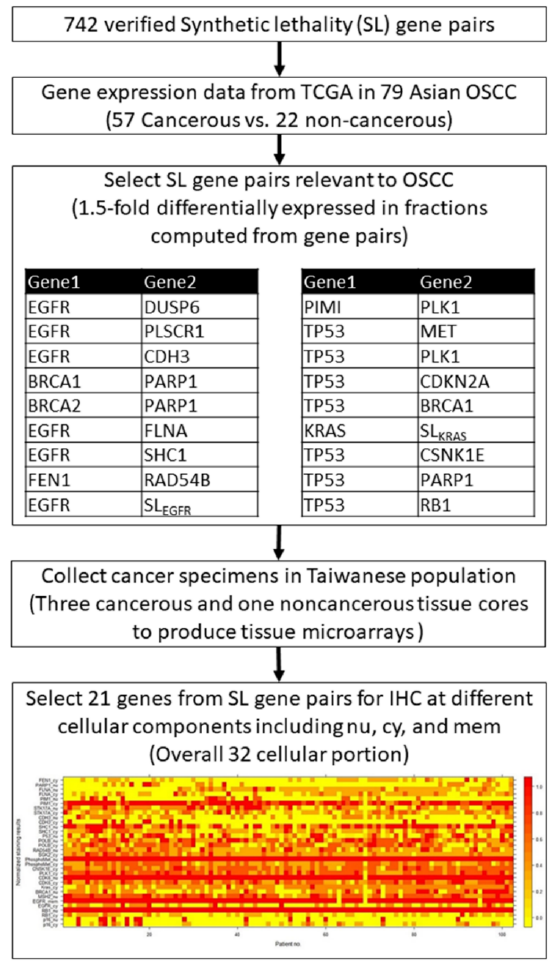
Figure 1. Study flowchart and the heatmap of protein staining matrix according to 32 individual IHC results. IHC